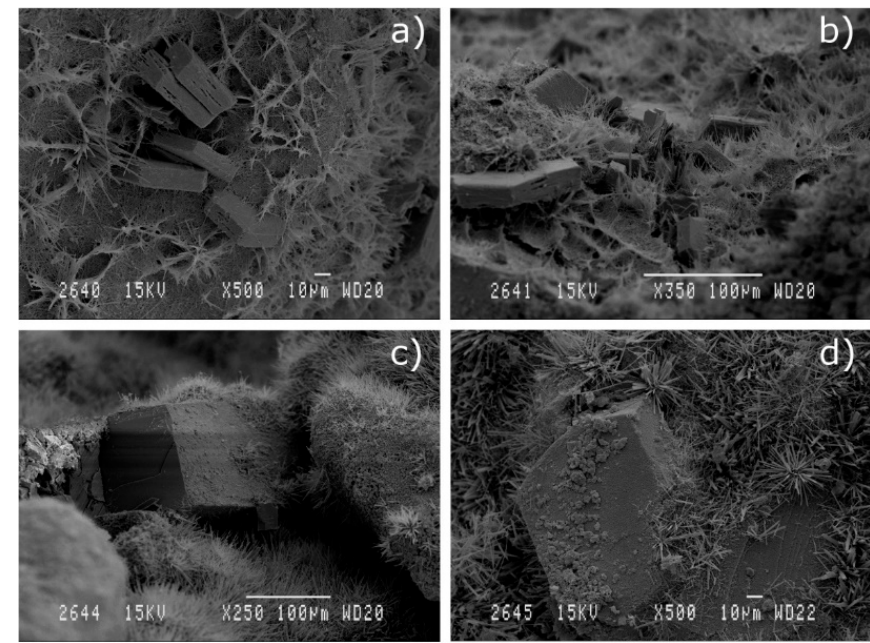
Figure 8. SEM micrographs of concrete samples 30’- SSA _water ( a ) and ( b ) and 30- SSA ( c , d ), cured for 90 days.